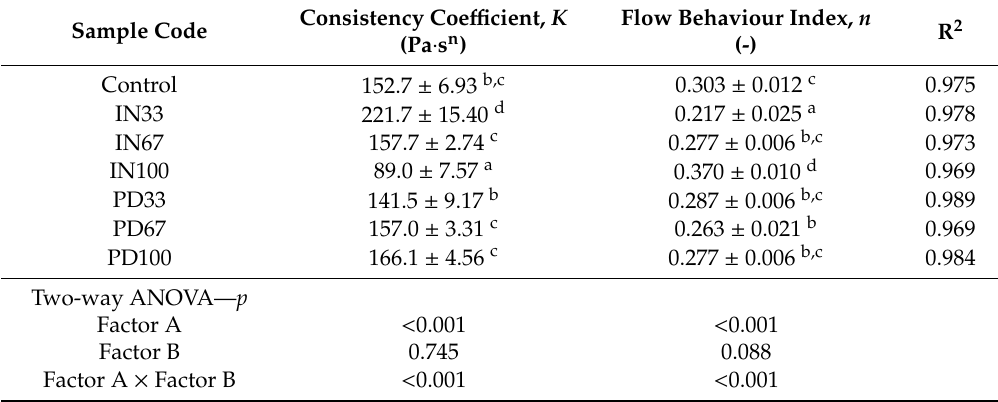
Figure 2. Viscosity curves of potato starch based desserts: without steviol glycosides (control), with inulin (IN33, IN67, IN100), with polydextrose (PD33, PD67, PD100). Table 3. Parameters of power law model describing flow curves of potato starch-milk